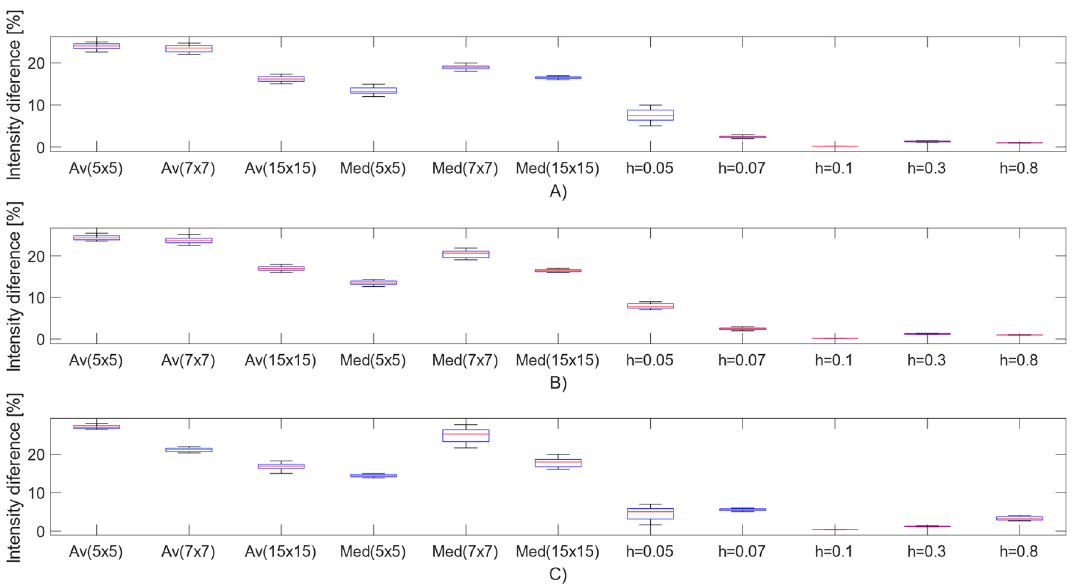
Figure 7. Intensity difference distribution of ( A ) Rician noise, ( B ) Salt and Pepper and ( C ) Speckle noise.